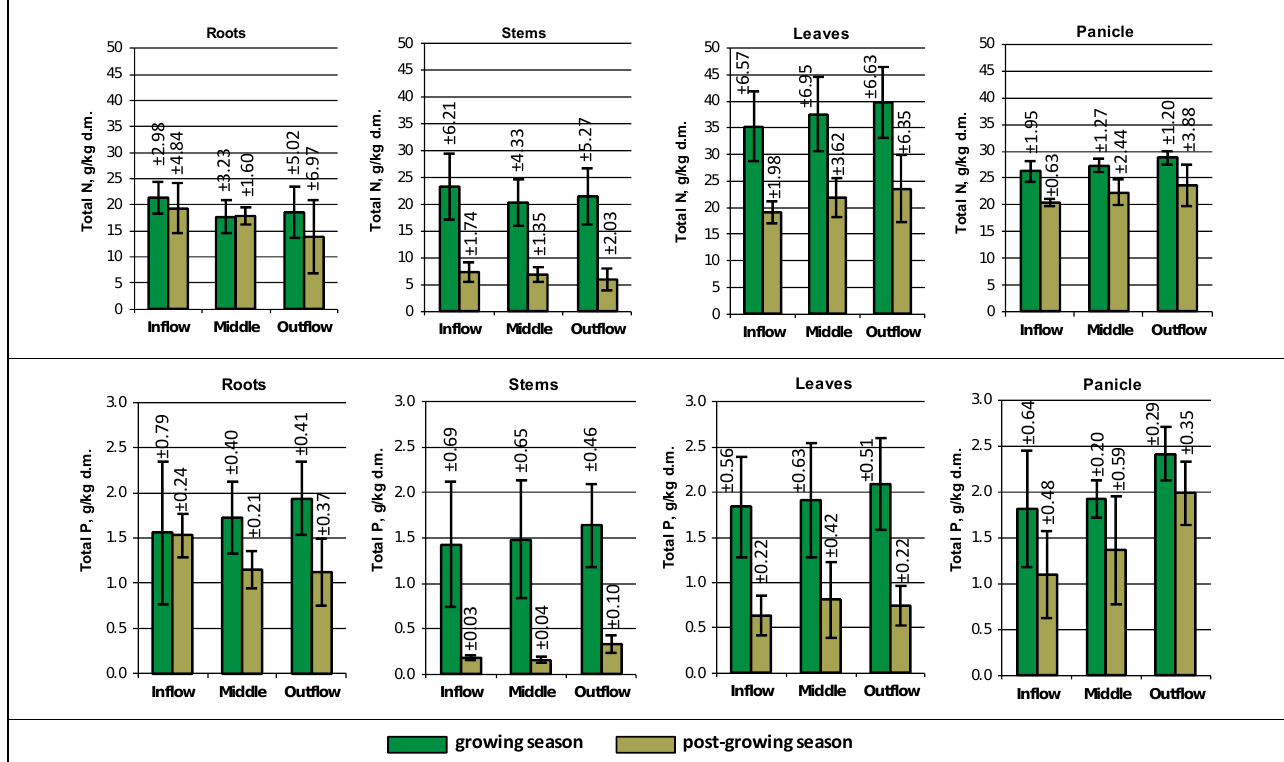
Figure 3. Seasonal dynamic concentration of TN and TP in the organs of P. australis. High seasonal changes in phytoaccumulation were also noted in the leaves of P. aus- tralis . The average value of nitrogen in the vegetative period was 37.56 g/kg d.m. In the off-season, the leaves contained 21.54 g/kg d.m. nitrogen. Both during the vegetative pe- riod as well as the period of dormancy, the nitrogen contents in the leaves of reeds were higher in plants collected near the end of the constructed wetland than in reeds from the first part of the bed. The average value of nitrogen in leaf samples collected from the be-